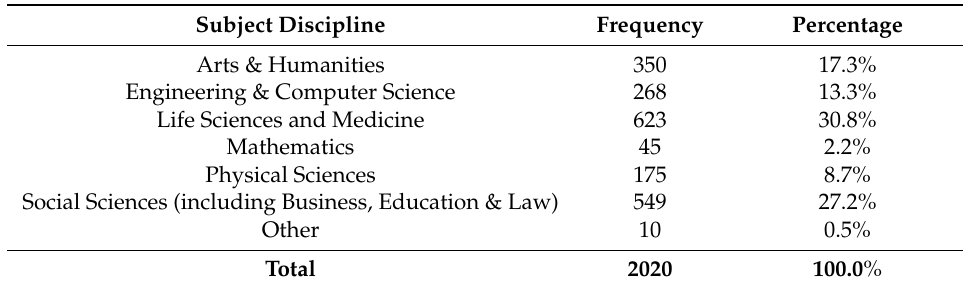
Table 2. Demographics: subject discipline of respondents.